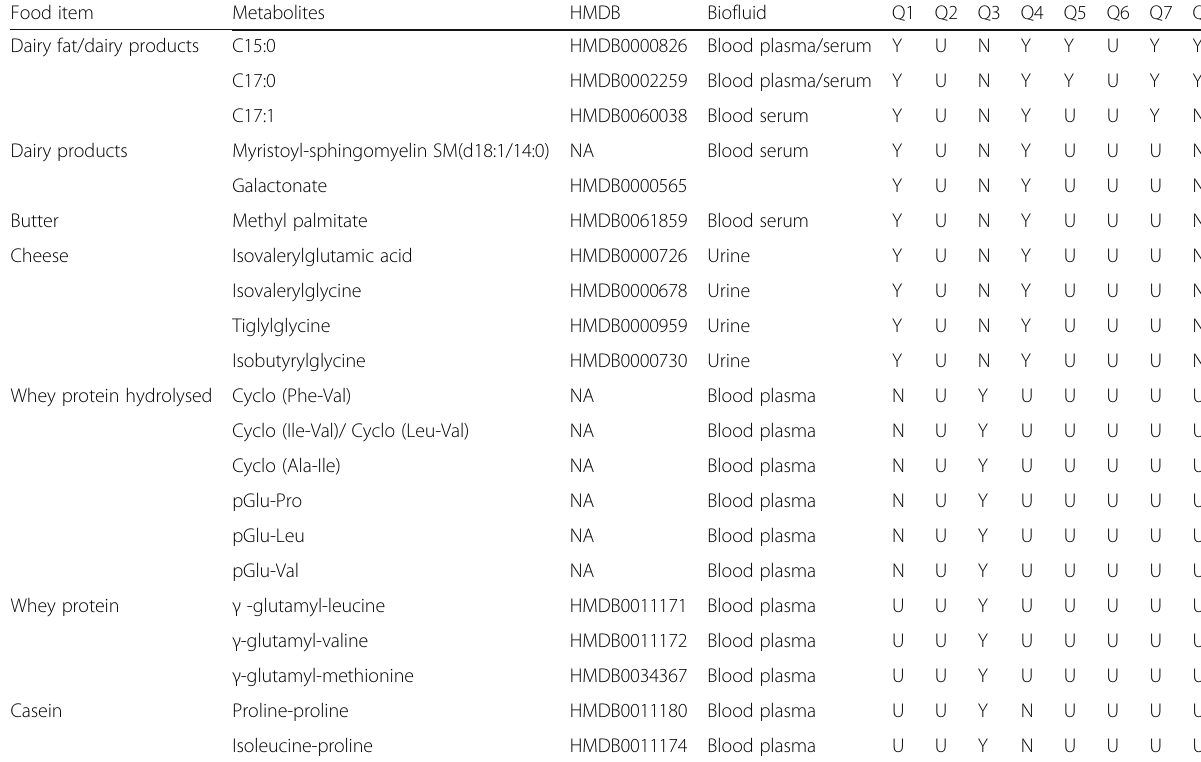
Table 2 Validation scheme for candidate intake biomarkers of dairy products. The questions Q1-Q8 are reported in Additional file 1: Table S10. Possible answers are Y (yes, the criterion is fulfilled for at least some use of the biomarker), N (no, the criterion has been investigated but it was not fulfilled), or U (uncertain, the criterion has not been investigated or data is not available). The questions are based on the criteria of Dragsted et al.